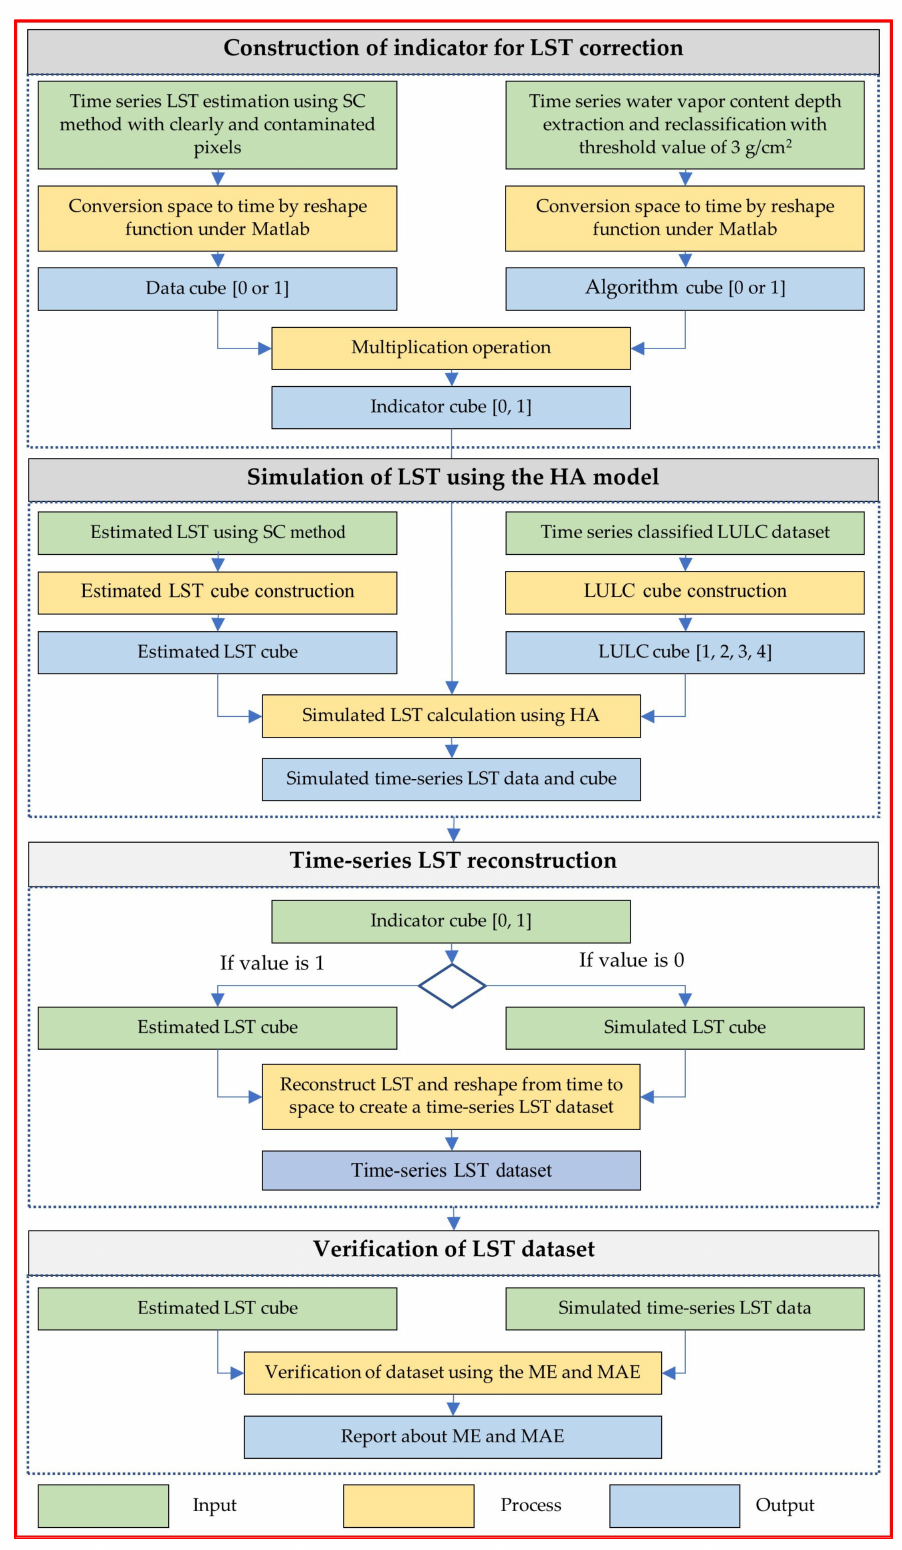
Figure 5. Workflow for time-series LST reconstruction and